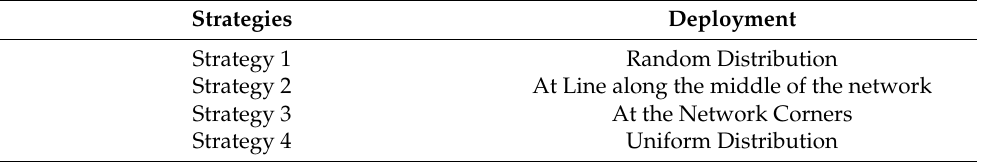
Table 6. Initial deployment strategies.